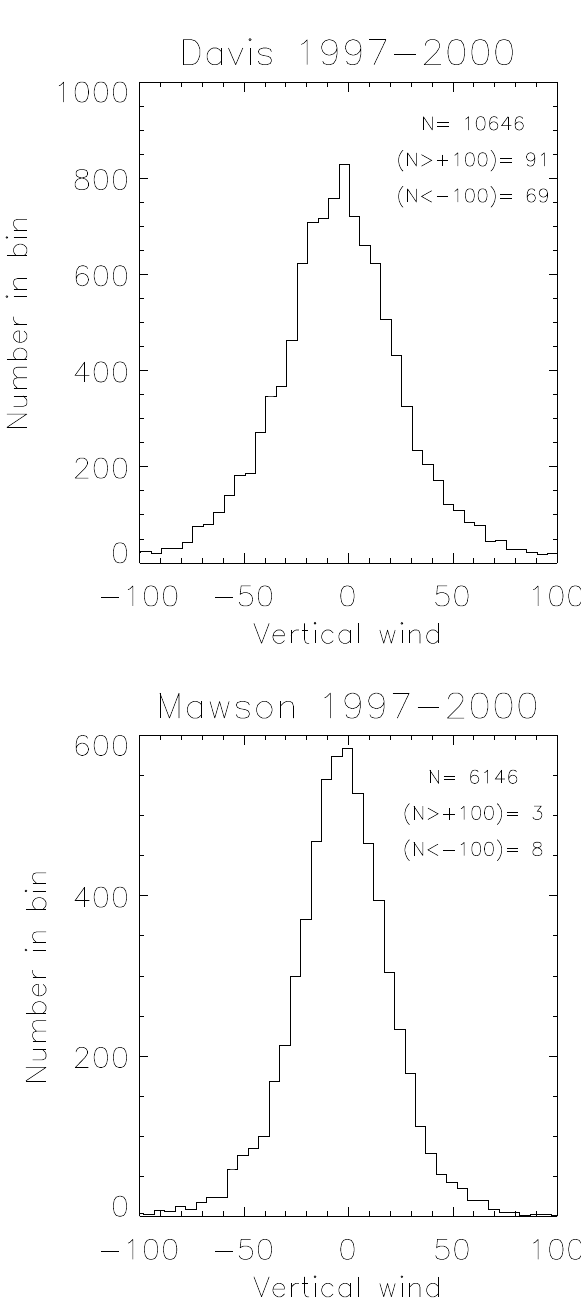
Fig. 4. Histograms of all vertical winds for the four years, 1997– 2000, for the two stations, Davis and Mawson. The total number of points in each analysis, together with the number of points greater than the maximum and less than the minimum shown, are displayed in the top